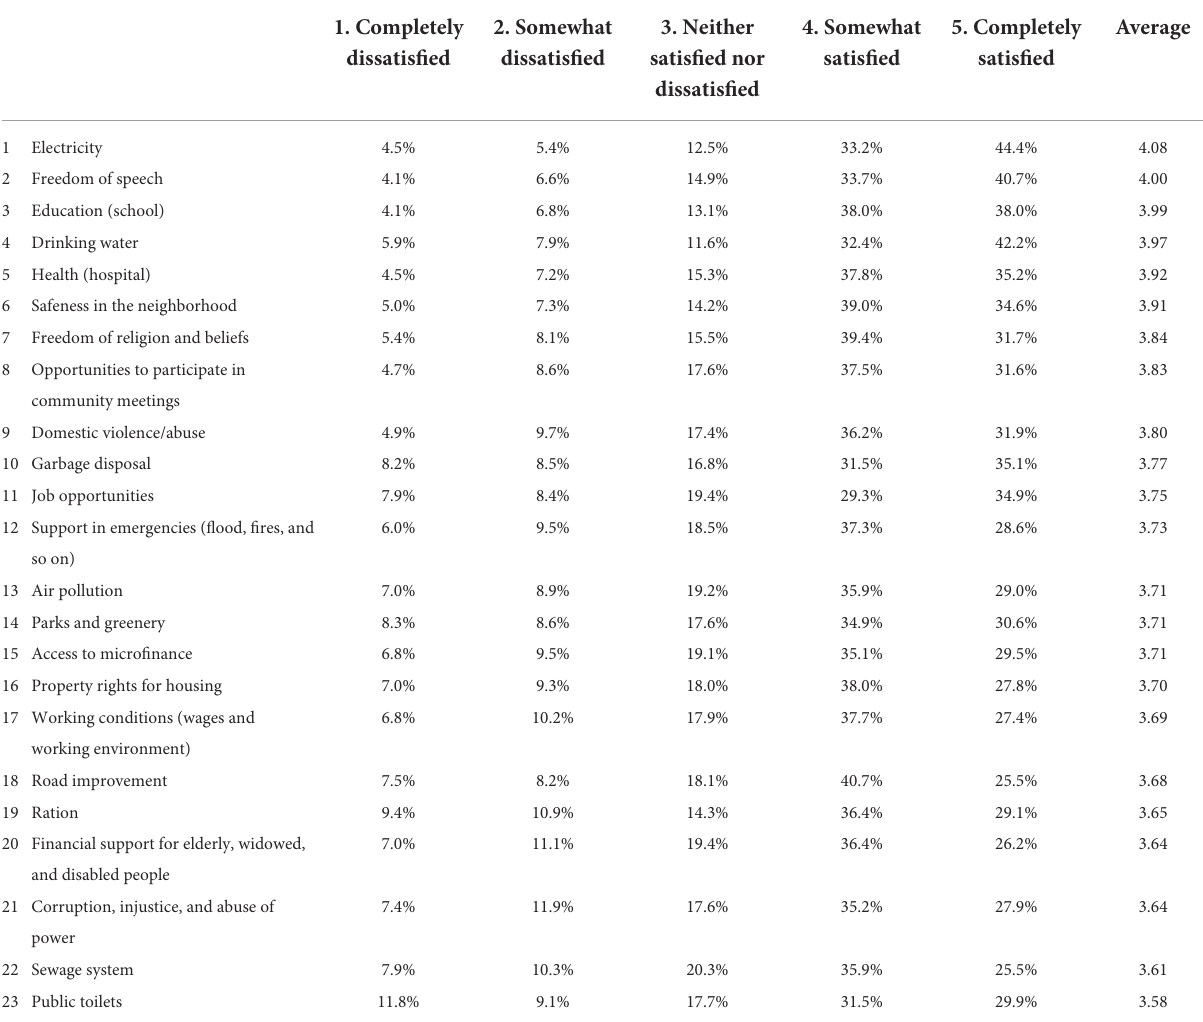
TABLE 2 Satisfaction with public